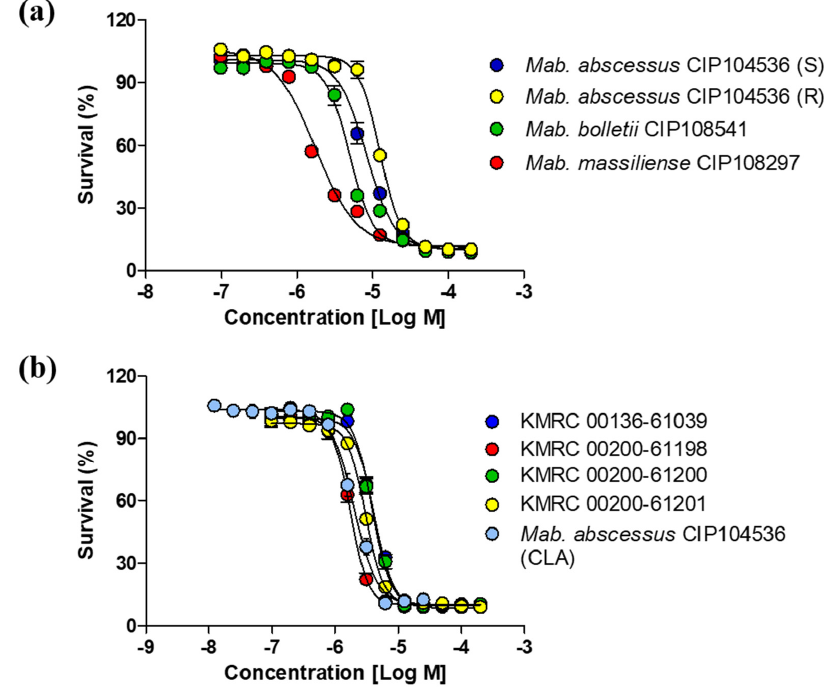
Figure 2. In vitro activity of etamycin for M. abscessus subspecies and clinical isolates. ( a ) Activity of etamycin against M. abscessus subsp. abscessus CIP 104536 T (S) and (R) morphotypes, M. abscessus subsp. massiliense CIP108297 T , and M. abscessus subsp. bolletii CIP108541 T was evaluated in